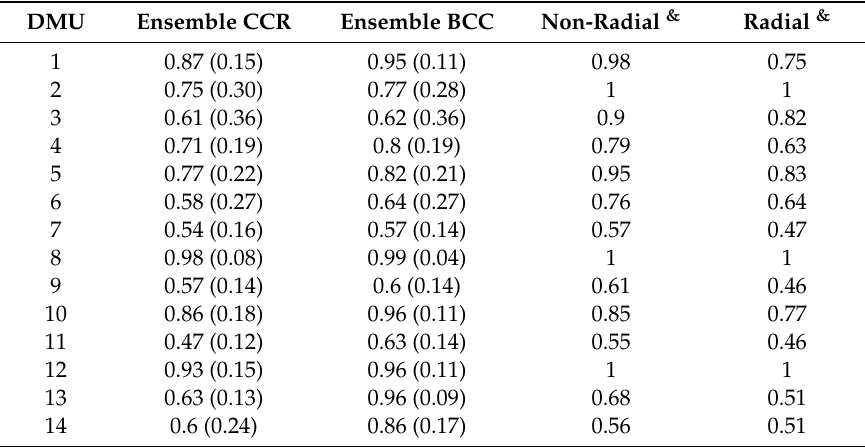
Table 3. The results of